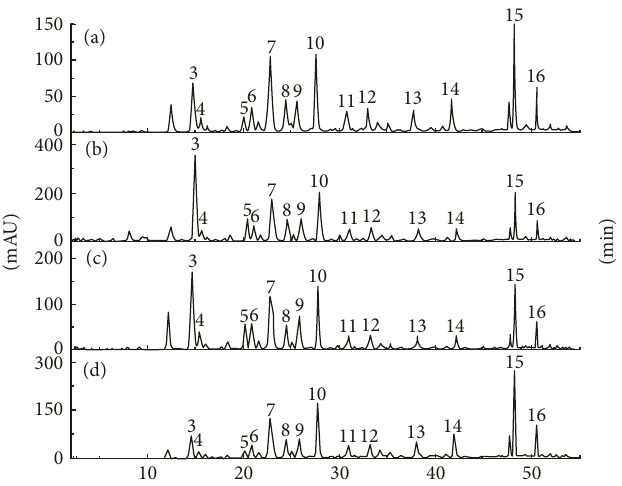
Figure 4: Chromatograms of lotus plumule from four di ff erent districts: (a) 50% part for XT; (b) 50% part for WY; (c) 50% part for JN; (d) 50% part for GC.